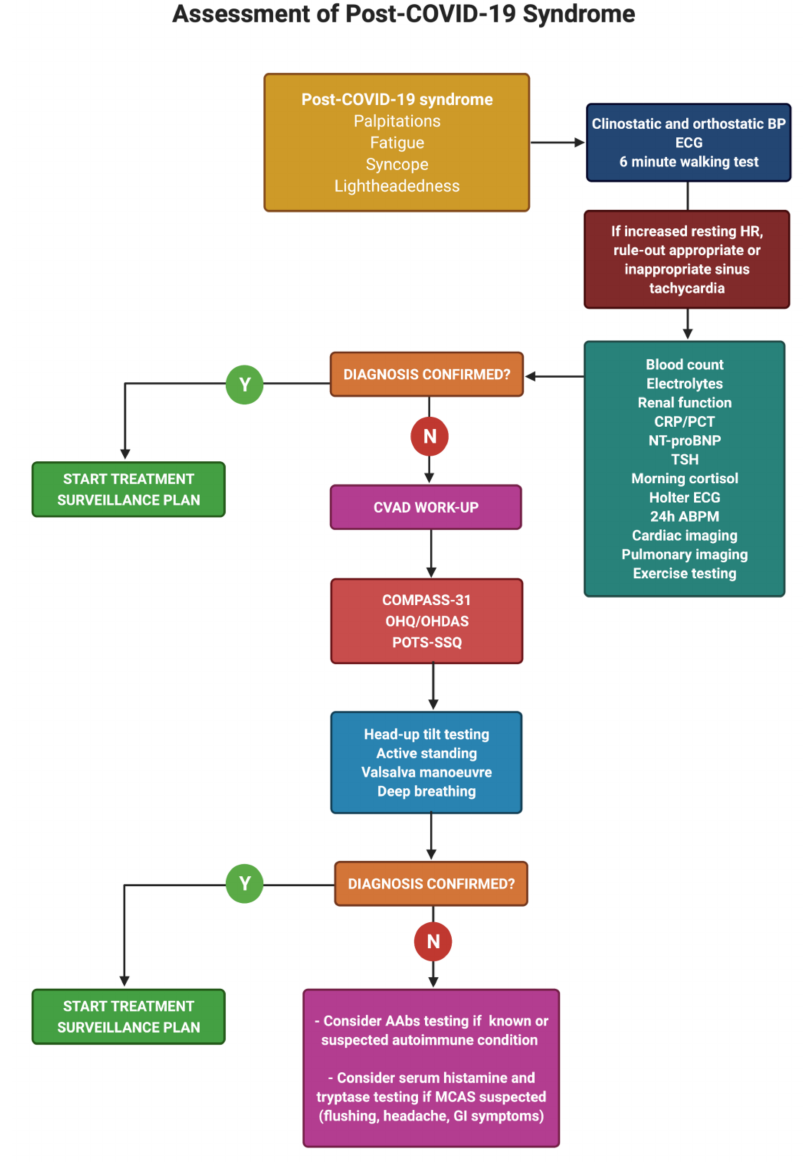
Figure 2. Assessment of post-COVID-19 Syndrome. AAbs, autoantibodies; ABPM, ambulatory blood pressure monitoring; BP, blood pressure; COMPASS-31, Composite Autonomic Symptom Scale 31; CRP, C-reactive protein; CVAD, cardiovascular autonomic dysfunction; ECG, electrocardiogram; GI, gastrointestinal; MCAS, mast cell activation syndrome; NT-proBNP, N-terminal prohormone of brain natriuretic peptide; OHDAS, orthostatic hypotension daily activity scale; OHQ, orthostatic hypotension questionnaire; PCT, procalcitonin; POTS-SSQ, postural orthostatic tachycardia syn- drome symptom scoring questionnaire, as in Johannsson and colleagues [10]; TSH, thyroid stimu- lating hormone. Created with